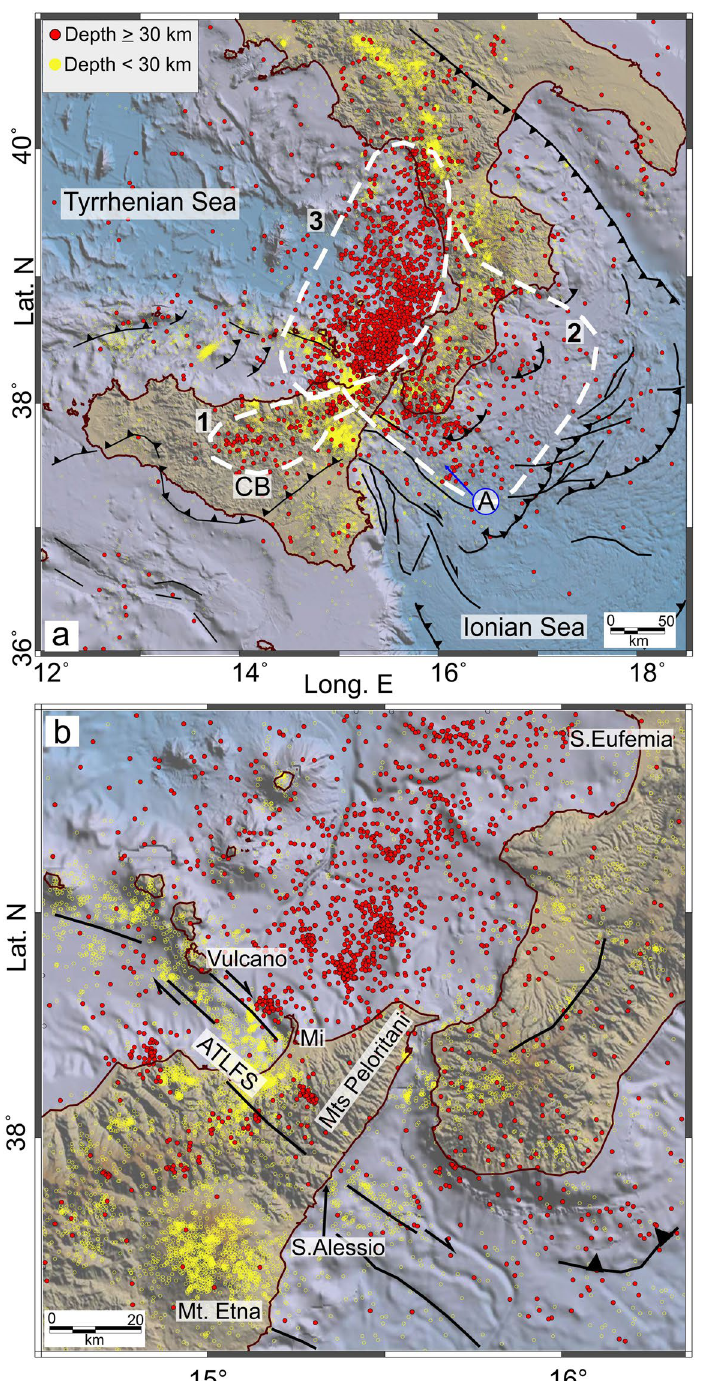
Figure 3. Final event locations. Numbers and white dashed lines denote the identified seismogenic domains (see Results for further details). The circled letter A indicates features described in the text. The main tectonic structures are also shown. Topography is from ref. 46 . The maps were created using QGIS (version 10.2.1; http:// qgis.org) and Generic Mapping Tools (GMT version 4.5.6; http://gmt.soest.hawaii.edu). The figure was edited using Corel Draw Graphics Suite (version X5;